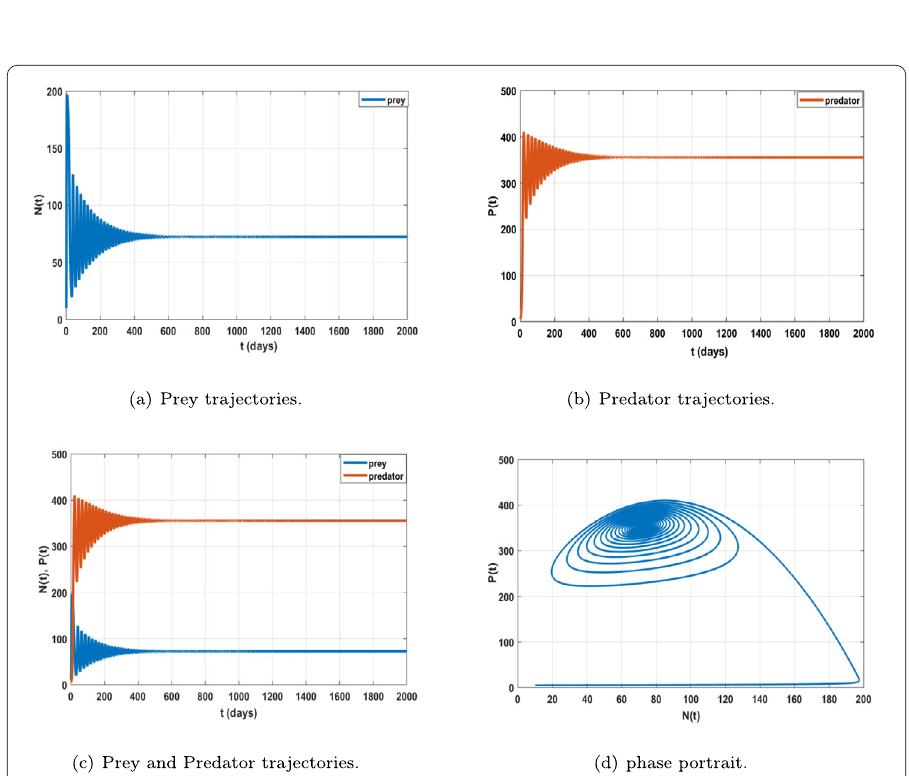
Figure 3 Global asymptotic stability of the coexisting equilibrium of system (2.3) around E 3 =